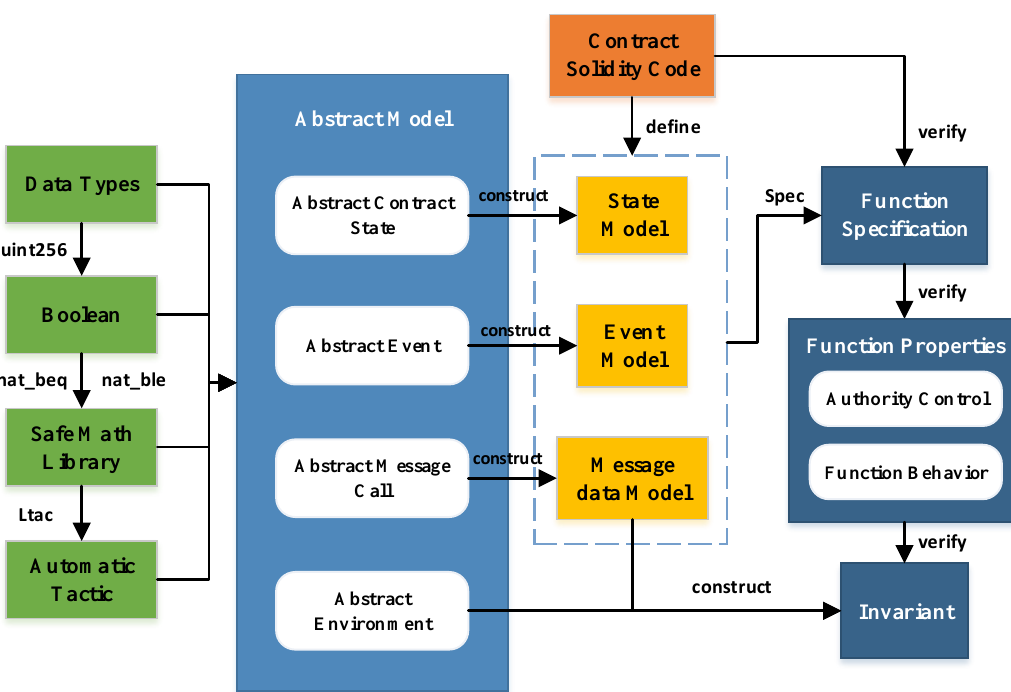
Figure 13. Formal verification framework for blockchain smart